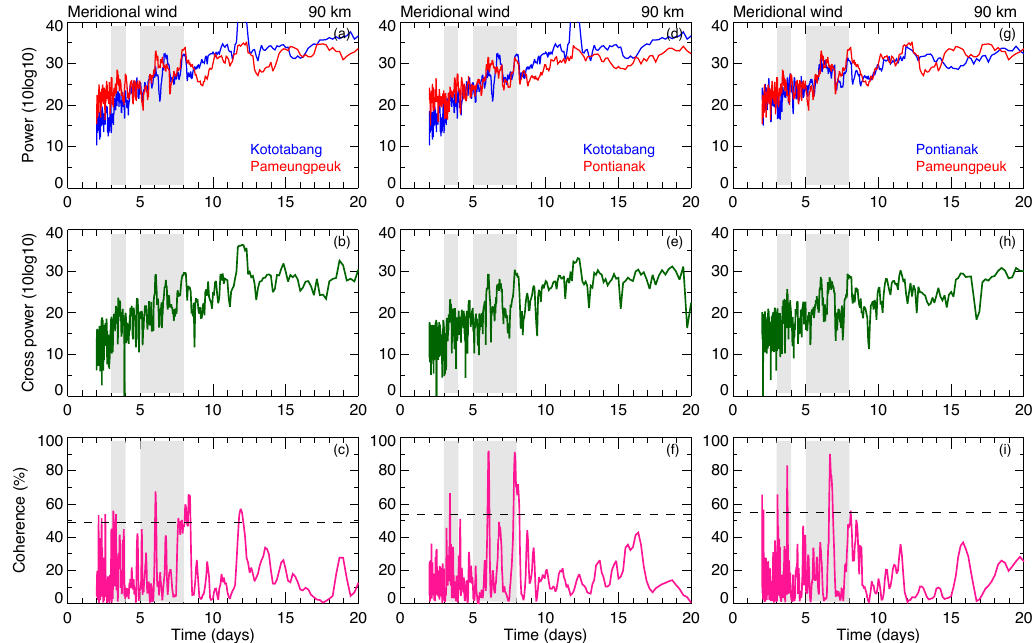
Figure 3. The meridional wind power spectral density of two radars (a, d, g) , cross power spectral density (b, e, h) , and coherence (c, f, i) during 1 April to 31 May